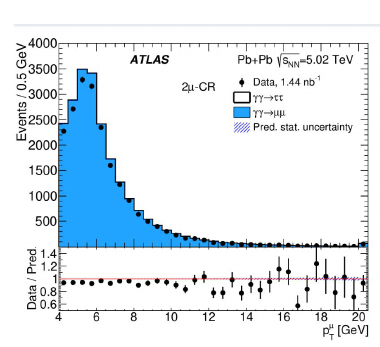
Figure 5. Leading muon p T -distribution in 2 µ -CR region [6].